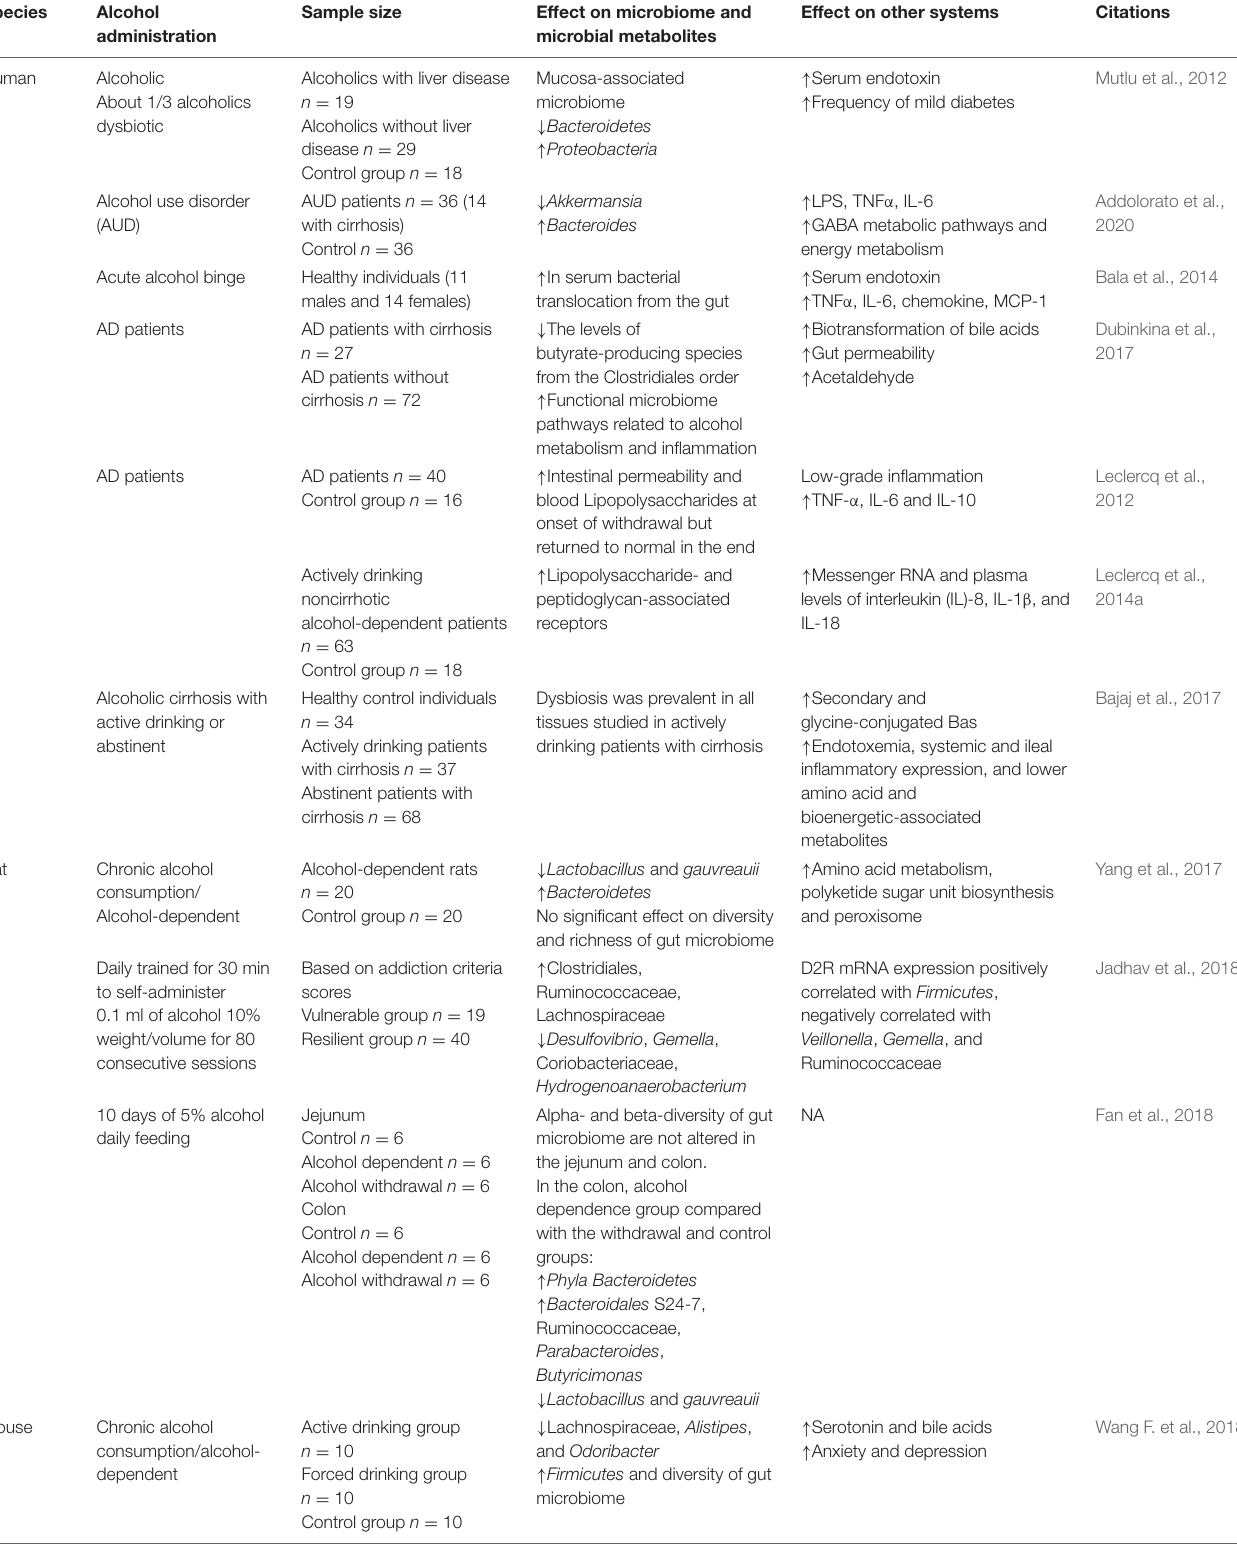
TABLE 1 | Effects of alcohol on gut microbiome and other